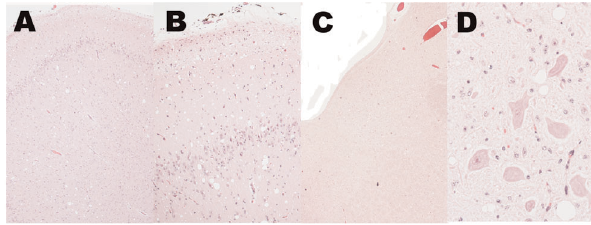
Figure 3. Spongiform change was present at all levels of the brain examined. ( A, B ) Vacuoles were numerous and evenly spread in the piriform cortex. Original magnification 4 6 and 10 6 , respectively. ( C, D ) The parasympathetic nucleus of the vagus nerve contained few but definitive spongiform lesions. Vacuoles occur predominantly in the neuropil rather than perikarya. Original magnification 2 6 and 40 6 , respectively.